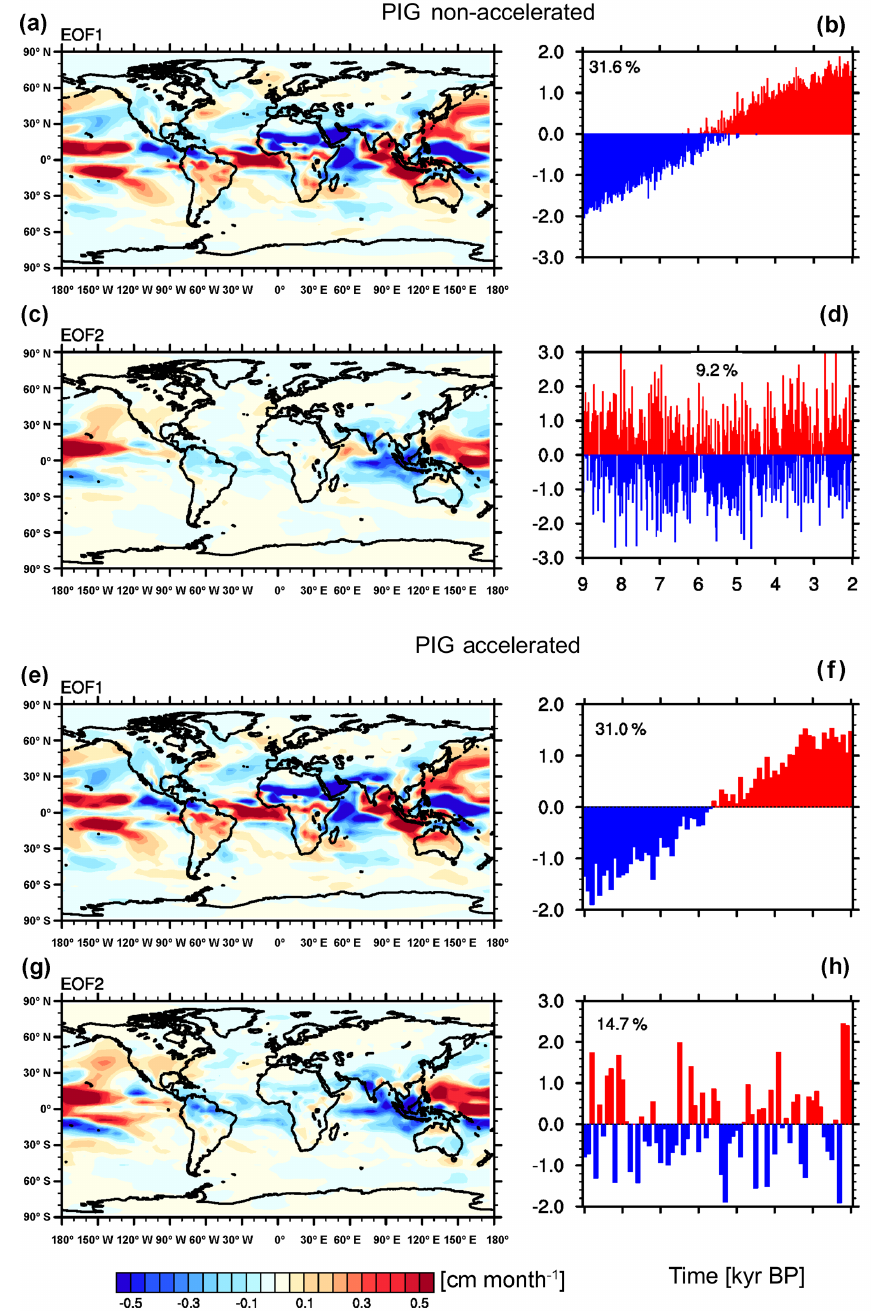
Figure 9. Same as Fig. 5 but for PIG